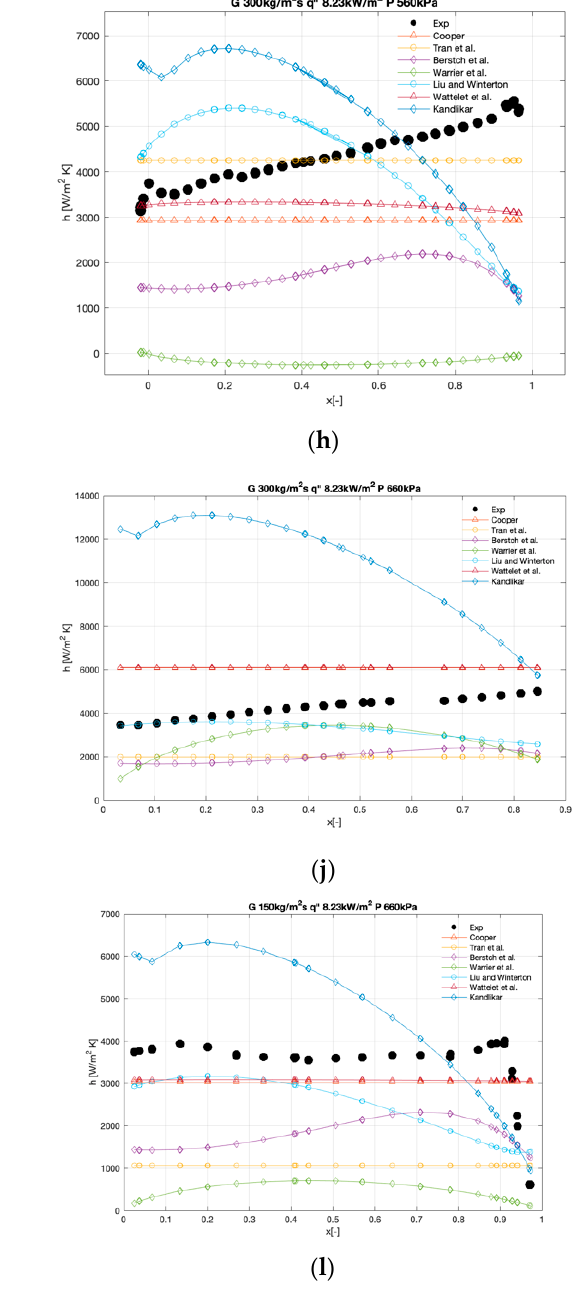
Figure 12. ( a – l ) Comparison of how predictive models of Cooper [30], Tran et al. [31], Berstch et al. [32], Warrier et al. [33], Wattelet et al. [34], Liu and Winterton [35] and Kandlikar [36] are able to capture experimental trend over vapor quality for conditions of G 150–300 kg/m 2 s, q ″ 8.26–23.3 kW/m 2 , P 460–660 kPa. Table 6. Statistical analysis of the comparison between experimental heat transfer coefficient and prediction models at saturation pressure of 460 kPa.